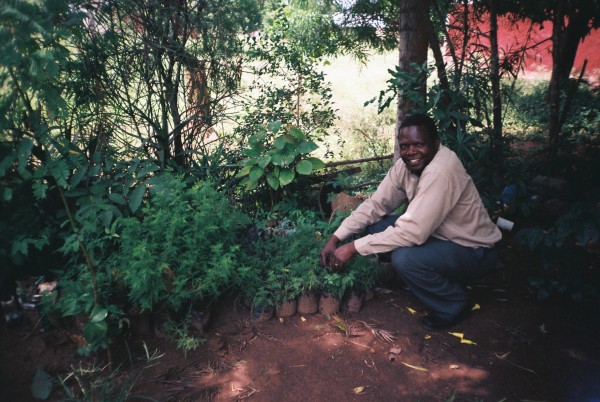
Pastor George Okuto (Kisumu, Kenya) has distributed Artemisia annua plants to over 200 people in his community.